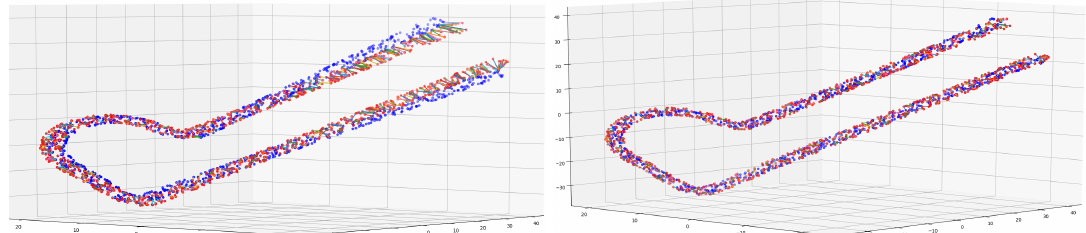
Figure 3. Elastic alignment example. Left image: rigidly aligned point clouds, right image: point clouds elastically aligned. Red points correspond to model while blue is a new sample to